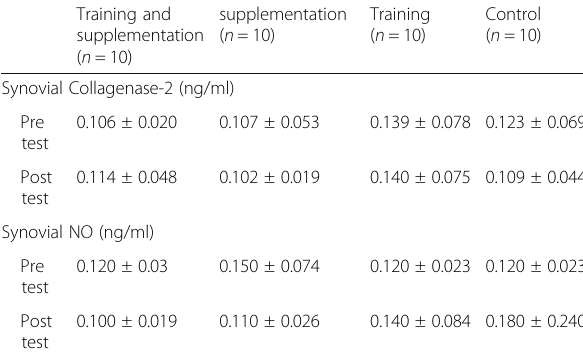
Table 3 Synovia levels of collagenase 2 and NO in pre and